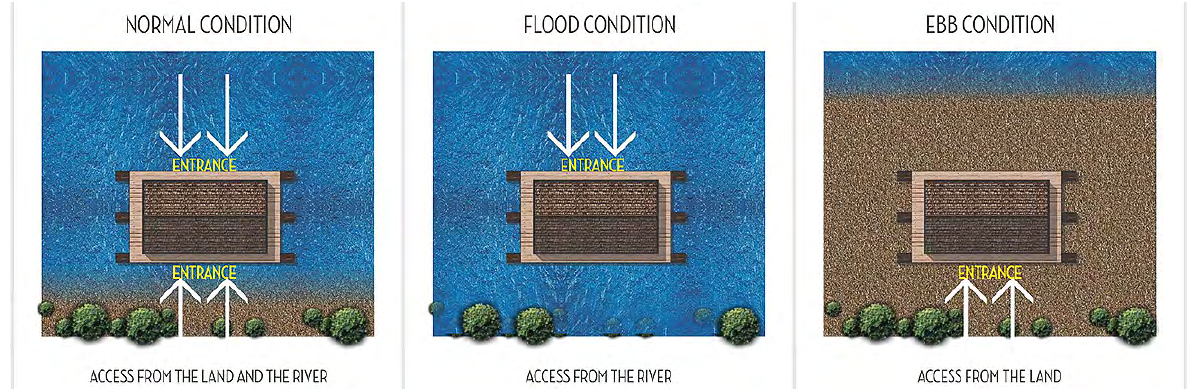
Figure 19. Access modification in floating